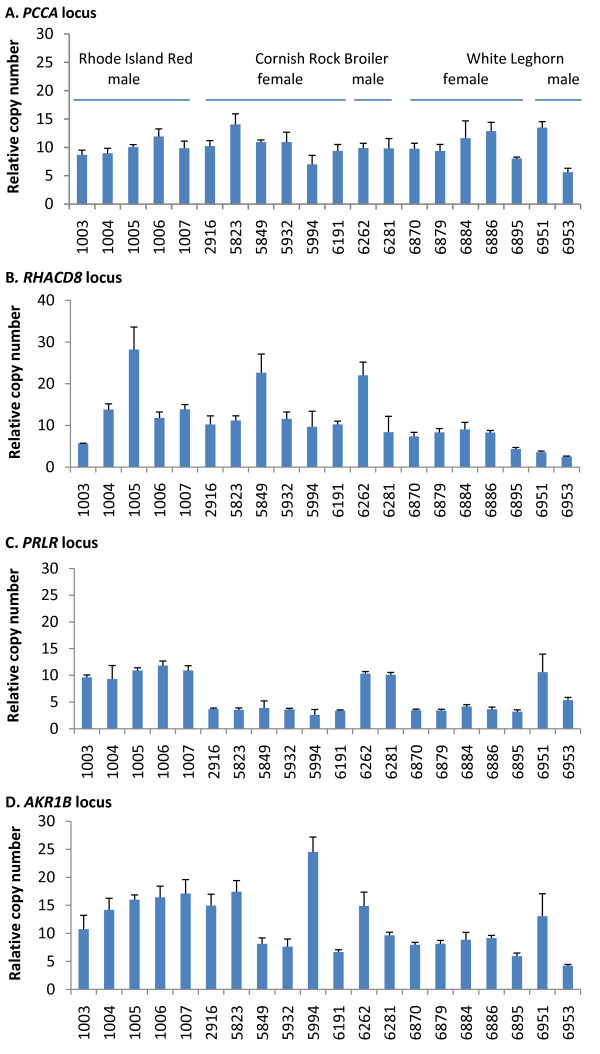
Quantitative PCR analysis of CNVs in 20 birds. DNA samples were diluted to 10 ng/μl and the conecentrations were meassured with Nanodrop spectrophotometer. Relative copy number was obtained by comparing threshold cyles of test DNA with a reference DNA that was serial diluted to 80, 20, 10 and 2.5 ng/μl. One unit of relative copies is the amount in 1 ng of reference DNA. Values represent mean ± SD of four reactions. Data were not normalized to the reference locus and copy number was not rounded. Numbers on x-axis are bird ID.